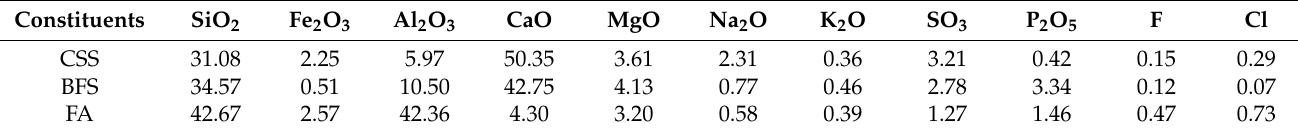
Table 1. The chemical constituents of raw materials (calculated by mass fraction